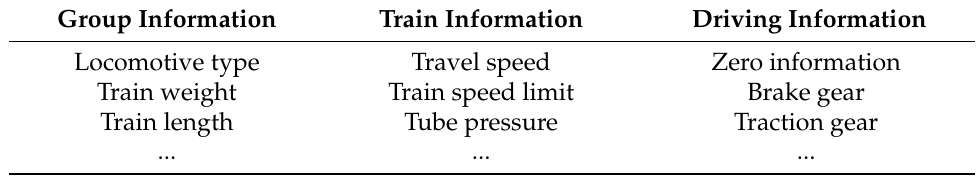
Table 1. Collected